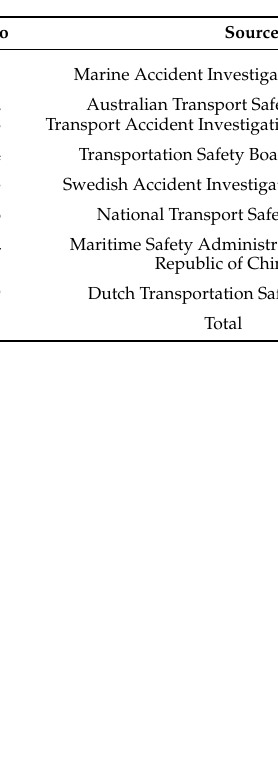
Table 1. Sources of the 207 global collision accident investigation reports.